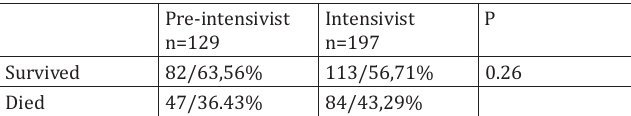
Survived 82/63,56% 113/56,71% 0.26 Died